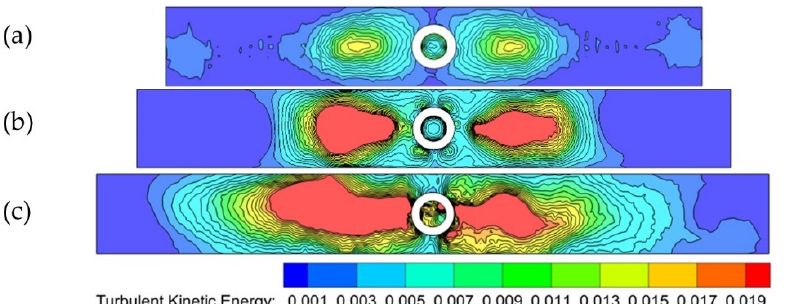
Figure 10. Turbulent kinetic energy contour on the top surface of the mold with different widths under high fixed steel throughput: ( a ) 1600 mm, ( b ) 1800 mm, and ( c ) 2000 mm.